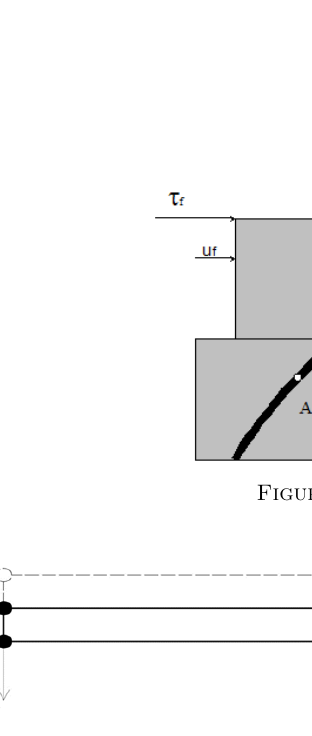
Figure 2. Scheme of a special bolt element: 1, 2 - nodes connected with surrounding rock; 3, 4 - nodes connected with the bolt